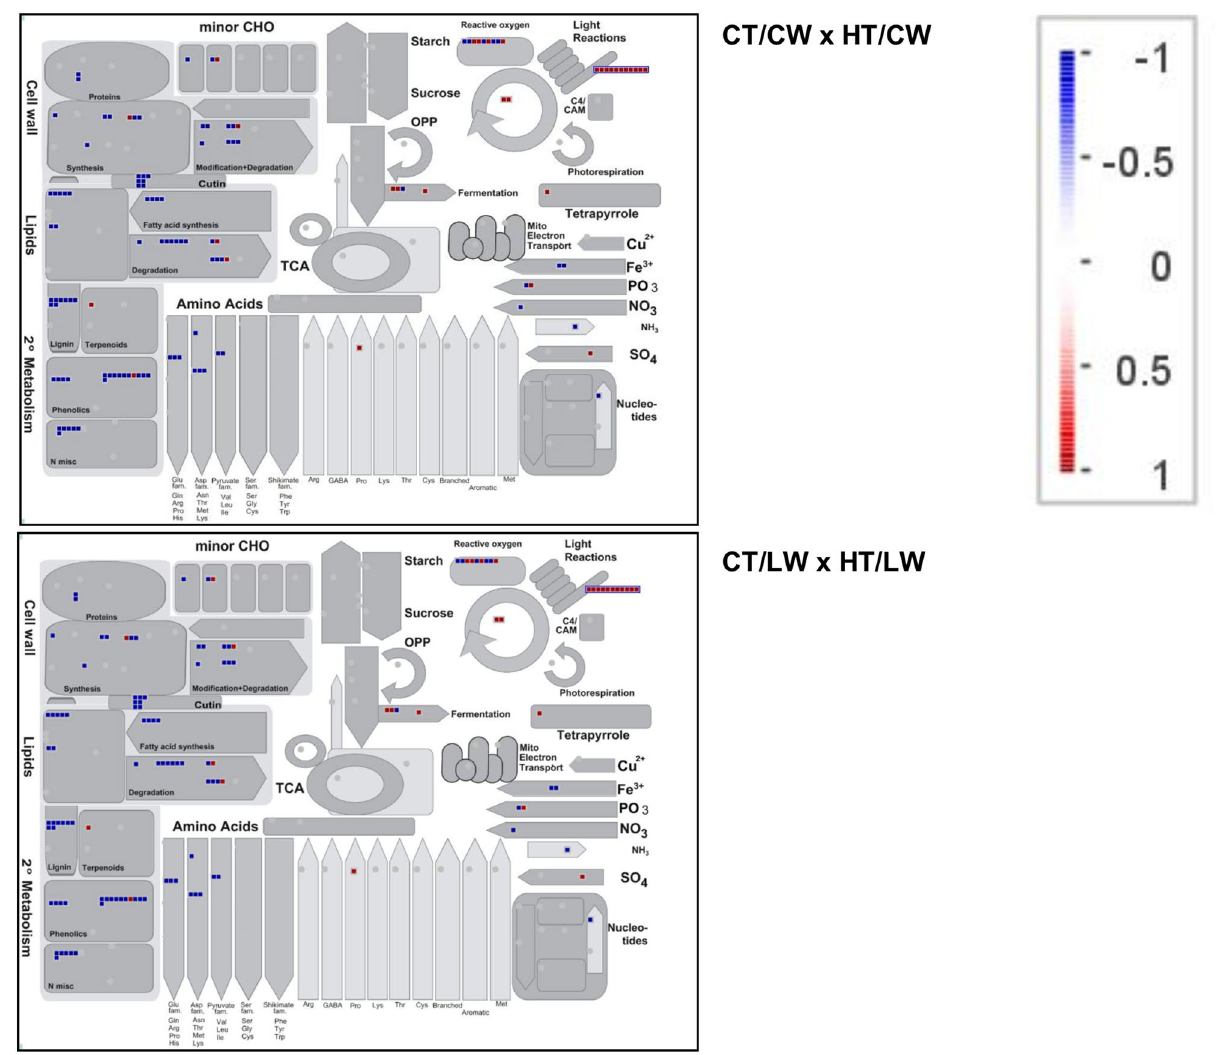
Figure 7. An overview map of metabolism pathways in root tissue affected by HT stress. Boxes represent a transcript annotated within each pathway, and color represents the relative degree of log-fold change in comparison to the control temperature (CT) treatment. Comparisons among CW and LW treatments were not possible due to differences in library